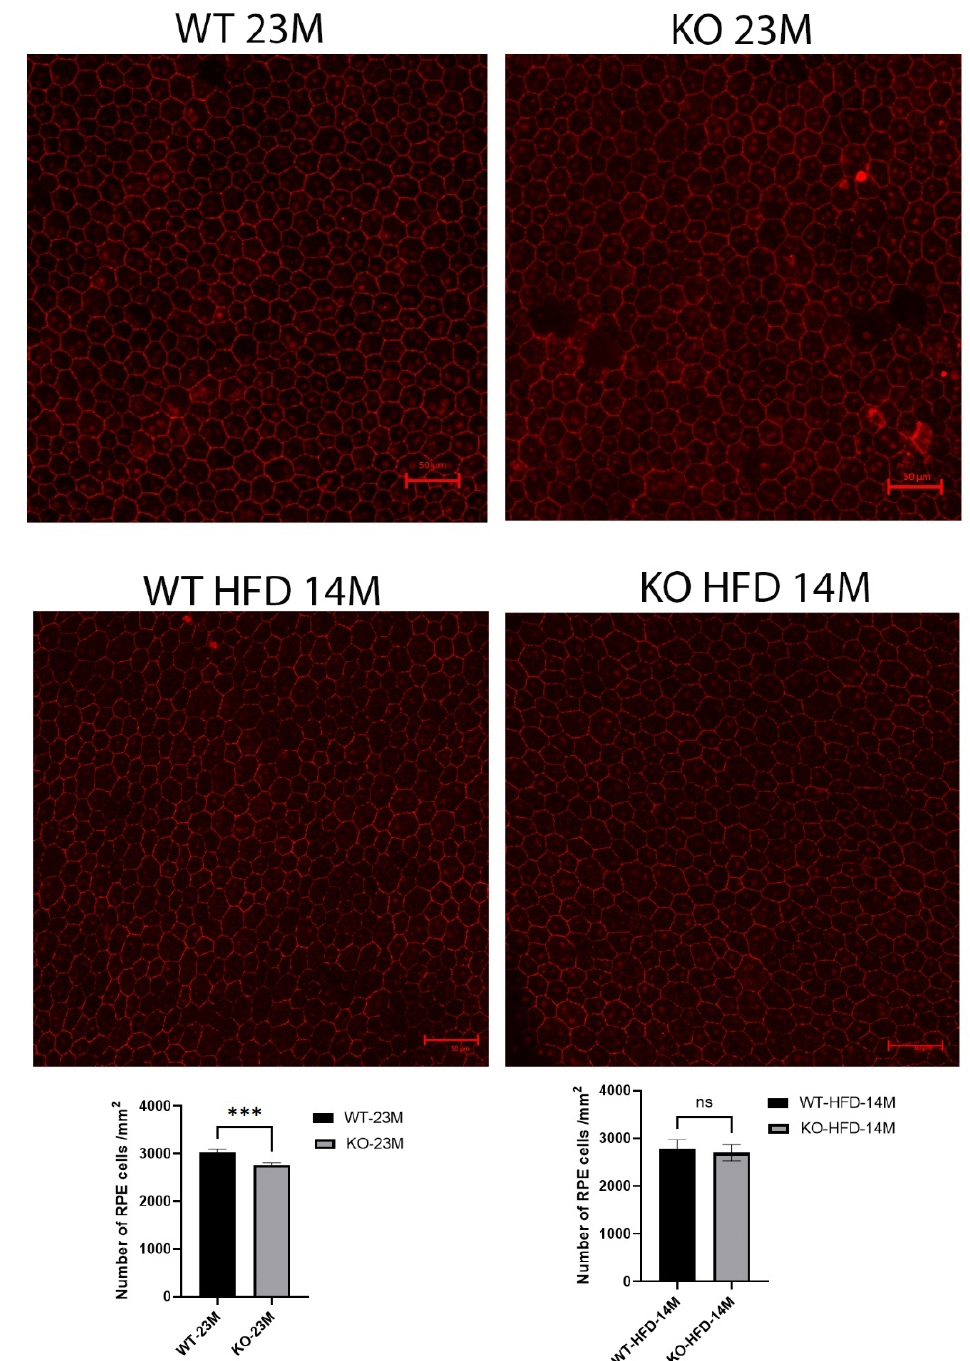
Figure 4. RPE-choroid flat-mount confocal immunofluorescence images with antibody to ZO-1 in 8 KO and 10 WT 23-month-old mice fed a regular diet and 5 KO and 5 WT 14-month-old mice fed the high-fat diet (because of deteriorating health beyond that age). The number of RPEs in the knockout mice was reduced slightly but with statistical significance ( p = 0.0003) compared to the same-age wild-type mice, while no difference was seen in the mice fed with a high-fat diet. Scale bar = 50 µm, ***: p < 0.001, ns: not significant.